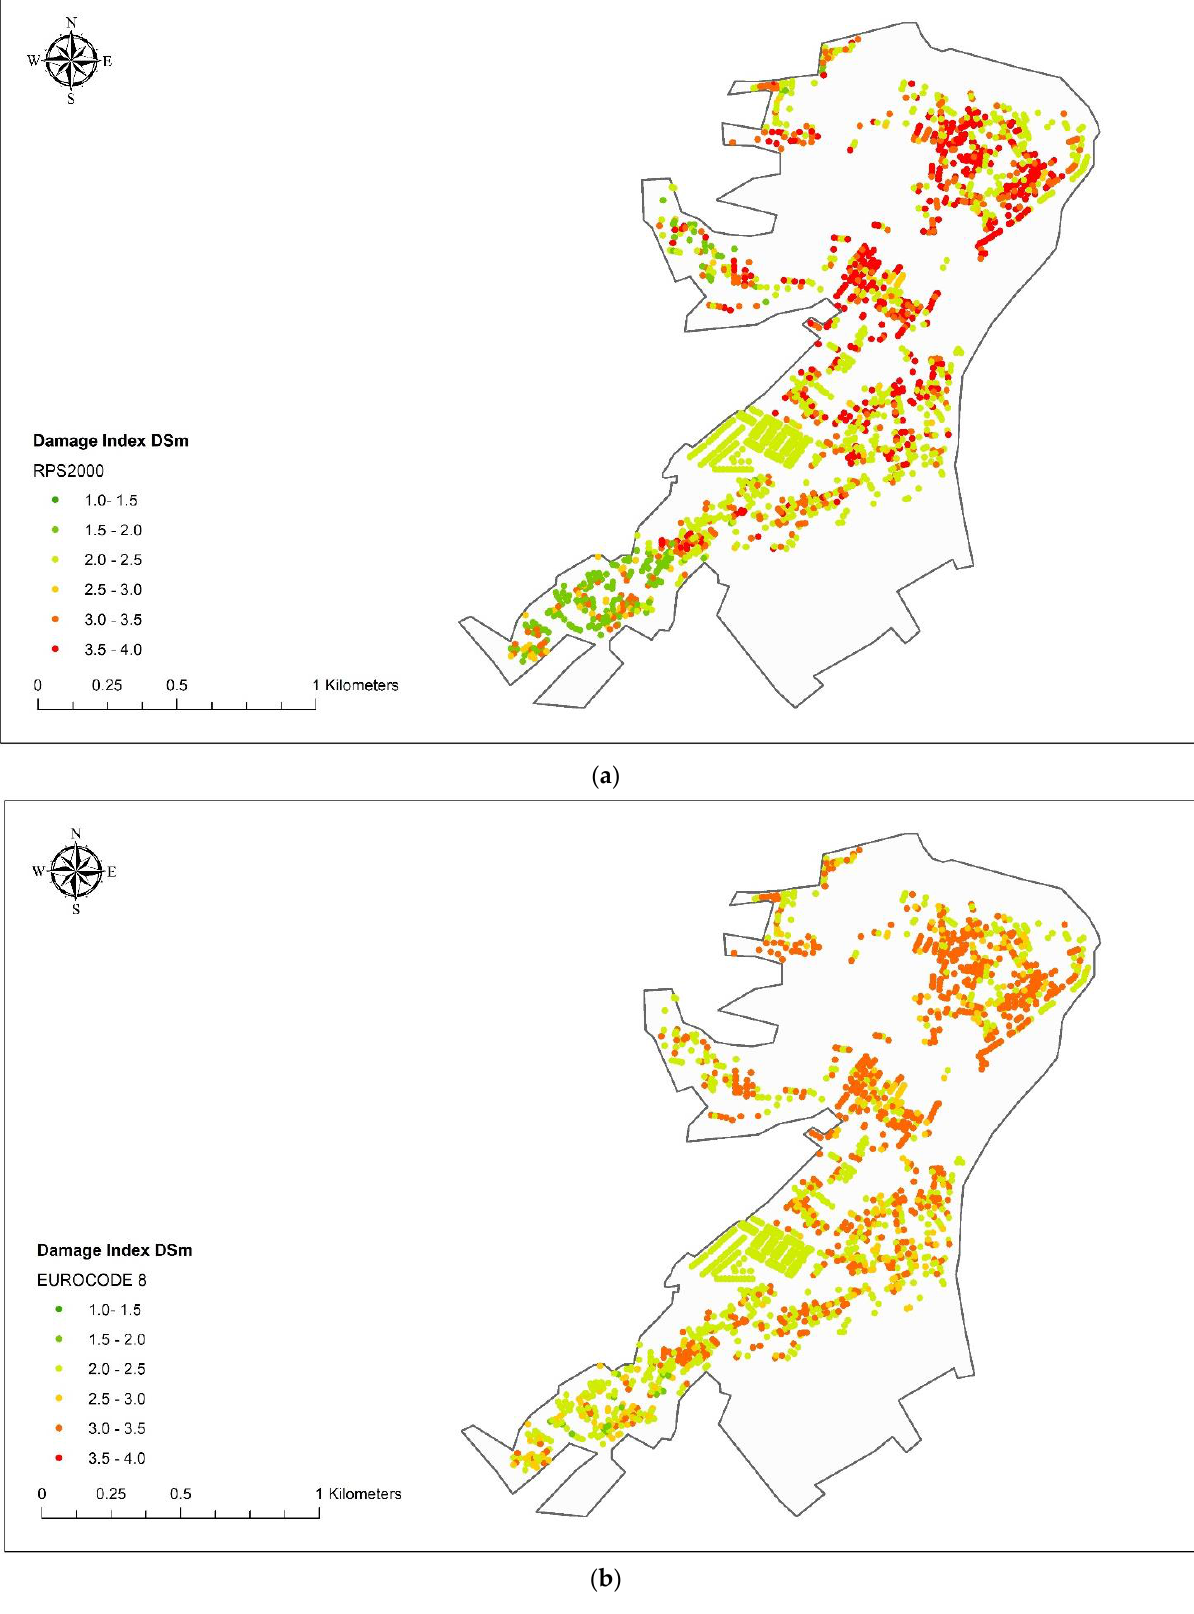
Figure 15. Damage distribution in the city of Imzouren following ( a ) the RPS2000 risk scenario and ( b ) the Eurocode 8 risk scenario.